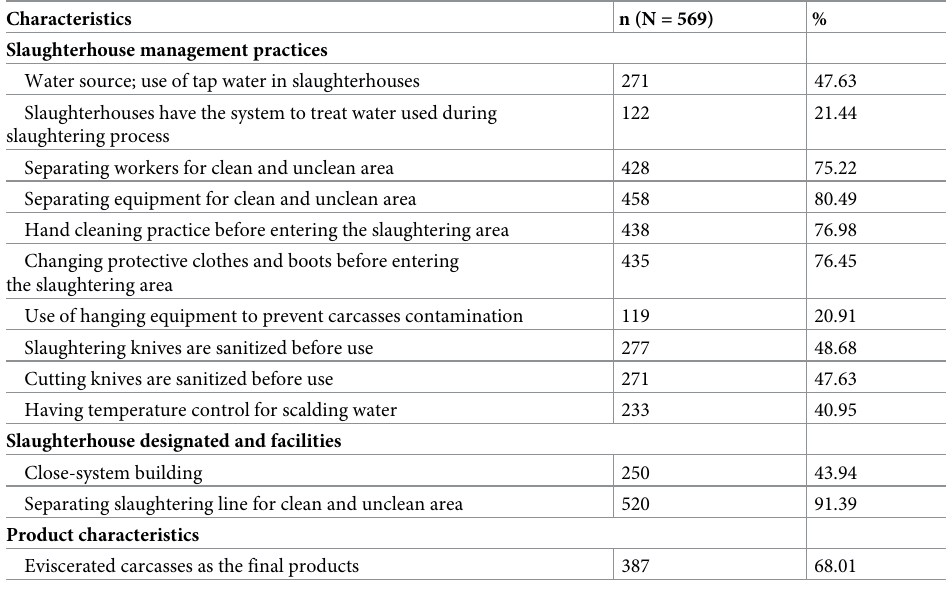
Table 1. The characteristics of the chicken slaughterhouses based on the questionnaire survey.